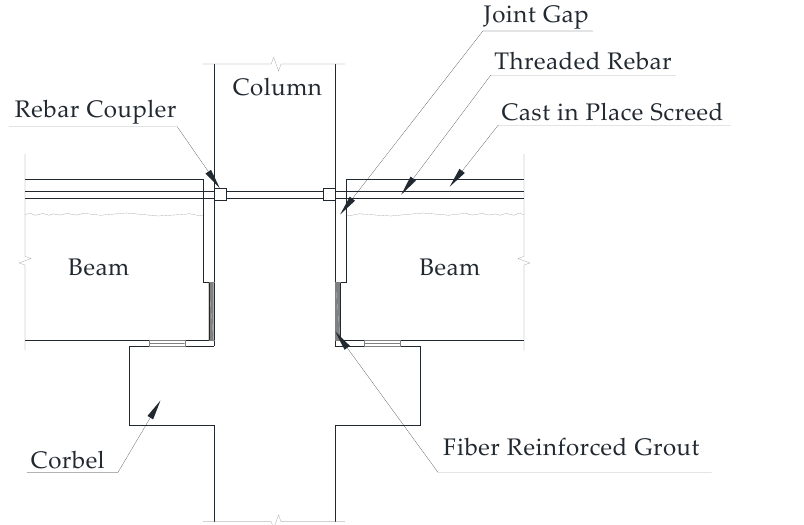
Figure 1. Vertical dog bones with threaded rebar [26].